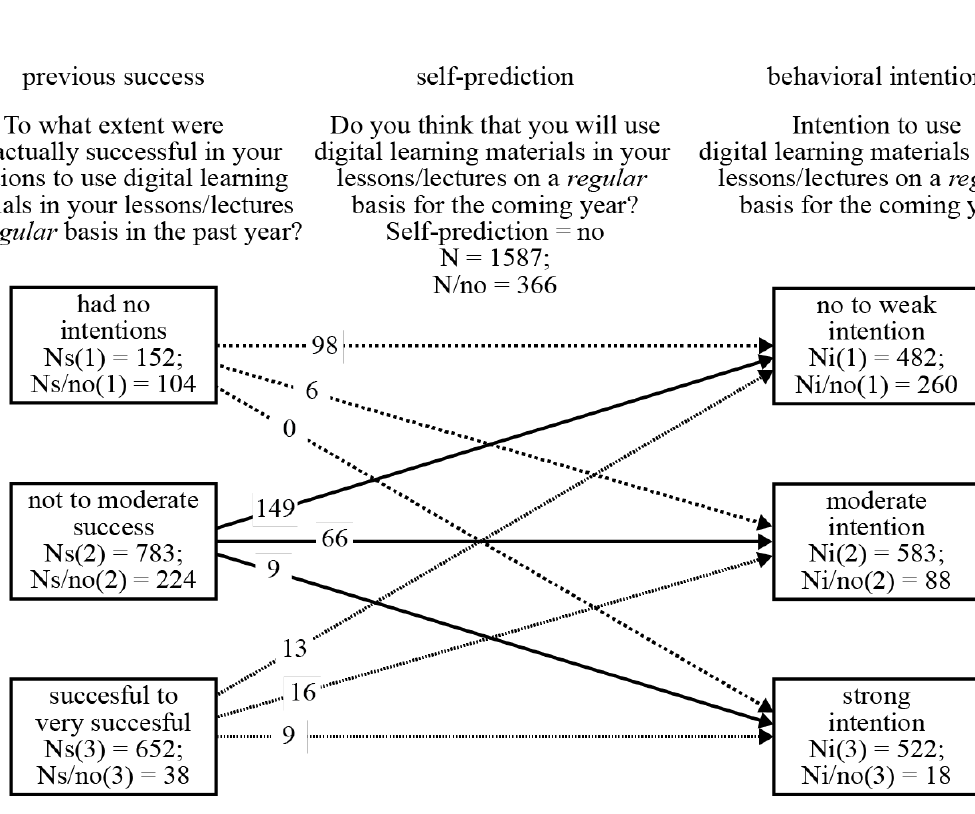
Figure 2b. Teachers flows for the population of teachers who predicted that they will not use DLMs regularly during